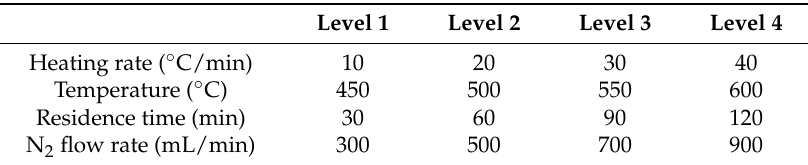
Table 2. Pyrolysis control factors and their levels.